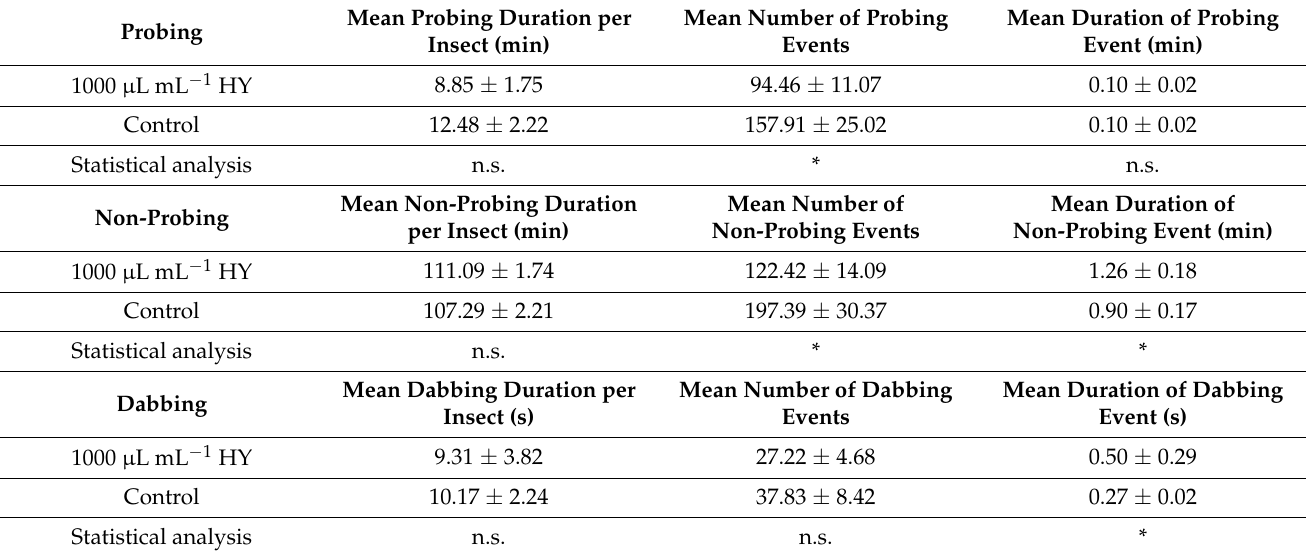
Table 2. Comparison of probing, non-probing, and dabbing phases (mean ± SEM) measured by EPG on D. suzukii females feeding on untreated and M. didyma HY-treated diets. n.s. = not significant at p < 0.05. * p < 0.05 according to non-parametric ANOVA Mann–Whitney U